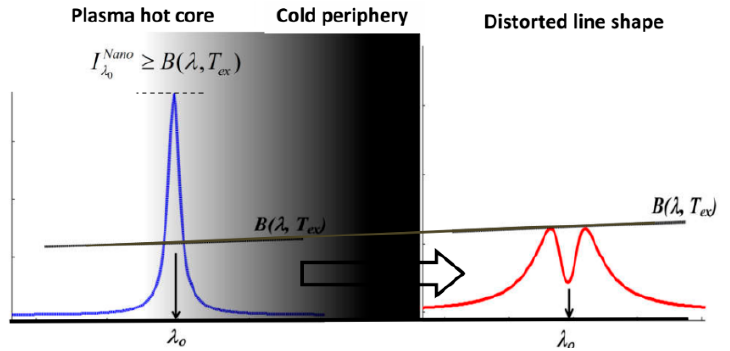
Figure 1. An illustration to the effect of plasma opacity on spectral line shape via self-reversal (red) in comparison to the undistorted shape (blue), together with the black body spectral intensity limit (black lines) for a specific excitation temperature at outer region of the plasma.